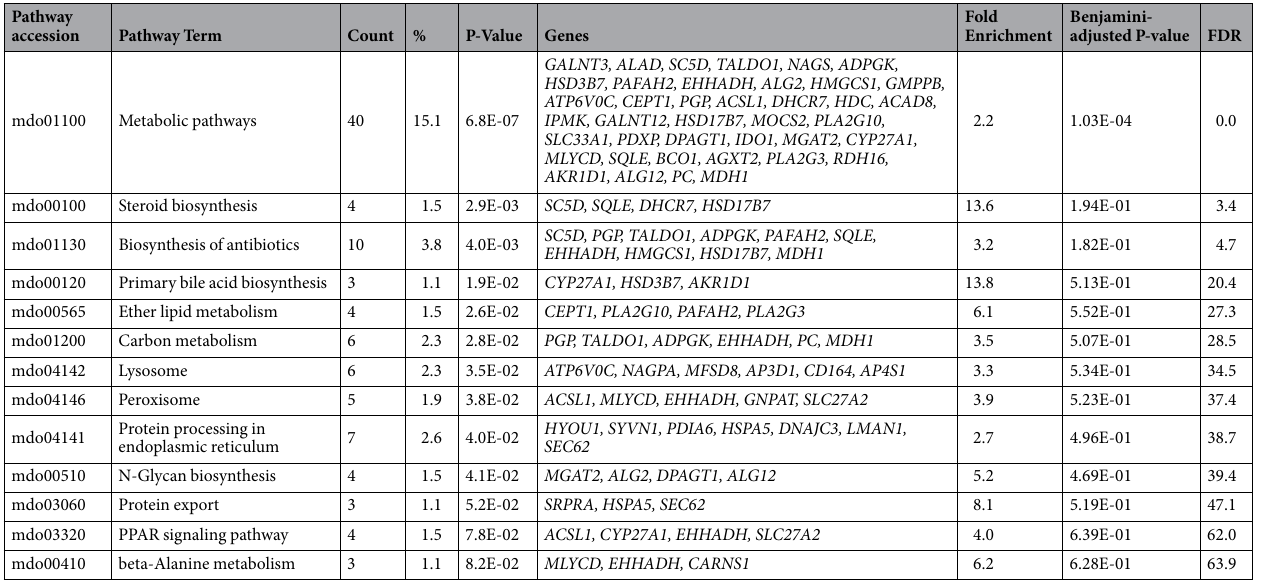
Table 3. KEGG pathways analysis using DAVID of genes upregulated during pregnancy. P-values are modified Fisher’s Exact P-Values for gene-enrichment analysis (where P = 0 represents perfect enrichment) and threshold 0.1, and only pathways with membership of at least two upregulated genes are shown. FDR = False discovery